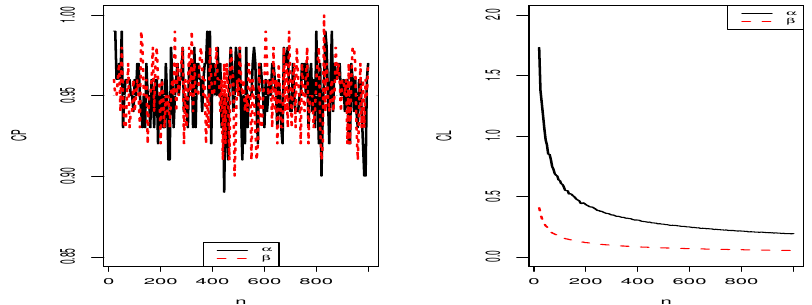
Figure 11. The empirical CLs and CPs of the MLEs for the